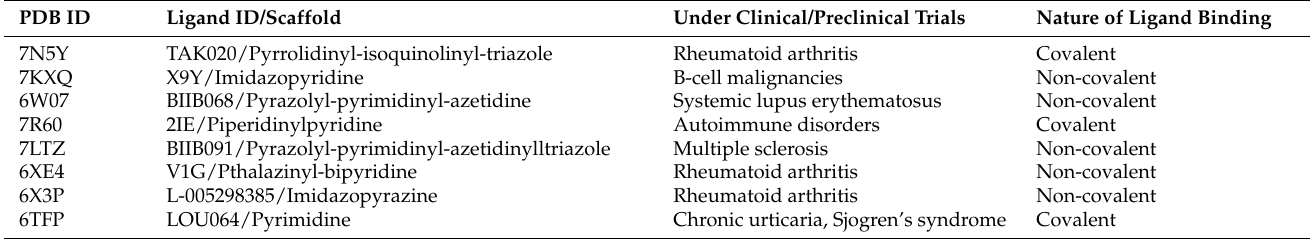
Table 3. PDB data of recent 3D structures of BTK-kinase domain with its complementary